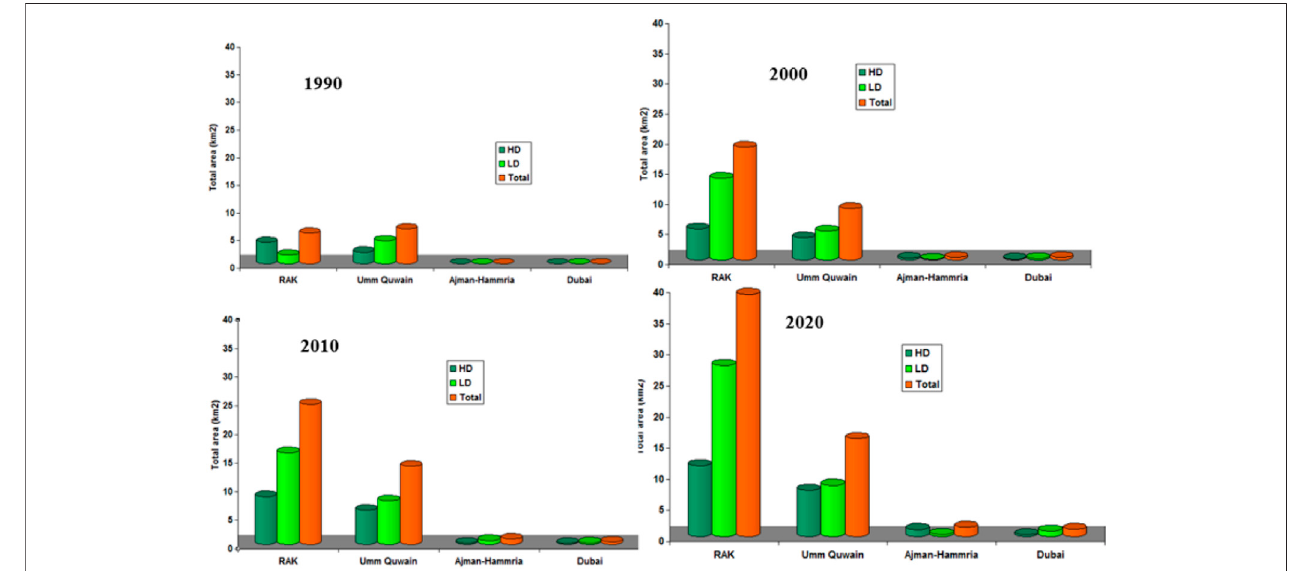
FIGURE 8 | Annual rate of the NUAE mangrove growth (classes and total area in km 2 ) during the period from 1990 to 2020.